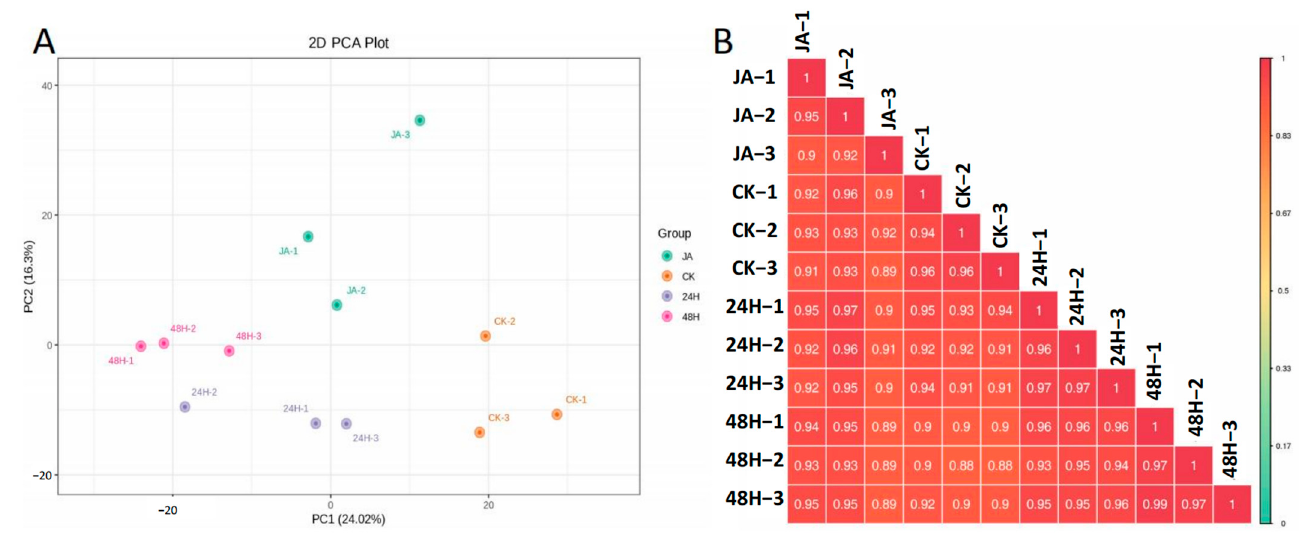
Figure 6. ( A ) PCA of primary metabolites from plants grown under control or induced conditions. Scores of Principle Component (PC) 1 are plotted against PC2. ( B ) Pearson’s correlation coefficients of metabolites in plants under different conditions. Table 3. Summary of differentially expressed metabolites in different